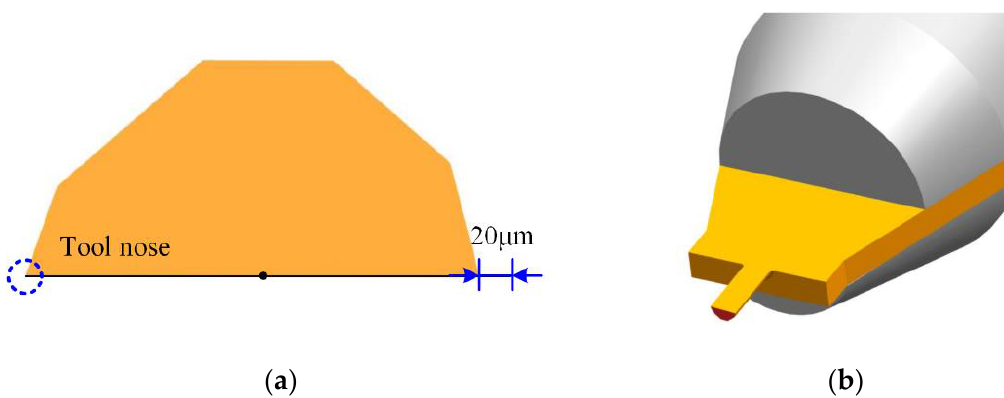
Figure 1. Schematic diagram of designed PCD micromilling cutter. ( a ) Asymmetric hexagon edge structure; ( b ) 3D model. Table 1. Geometric parameters of LAR PCD micromilling cutter. Parameters